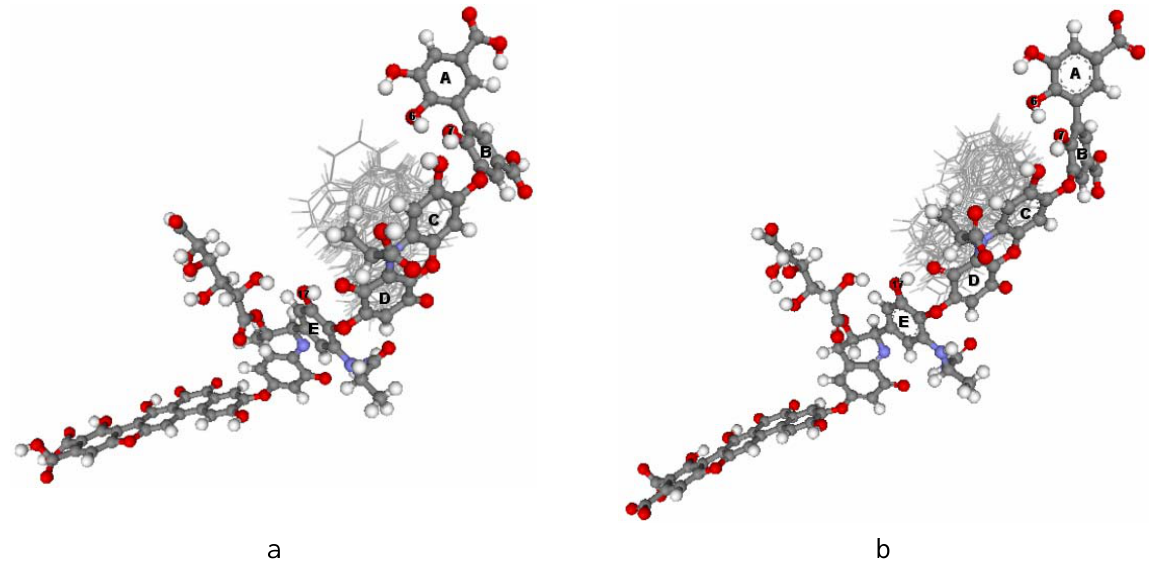
Figure 7 . Orientation of docked PAHs onto HA (a) and ionized HA